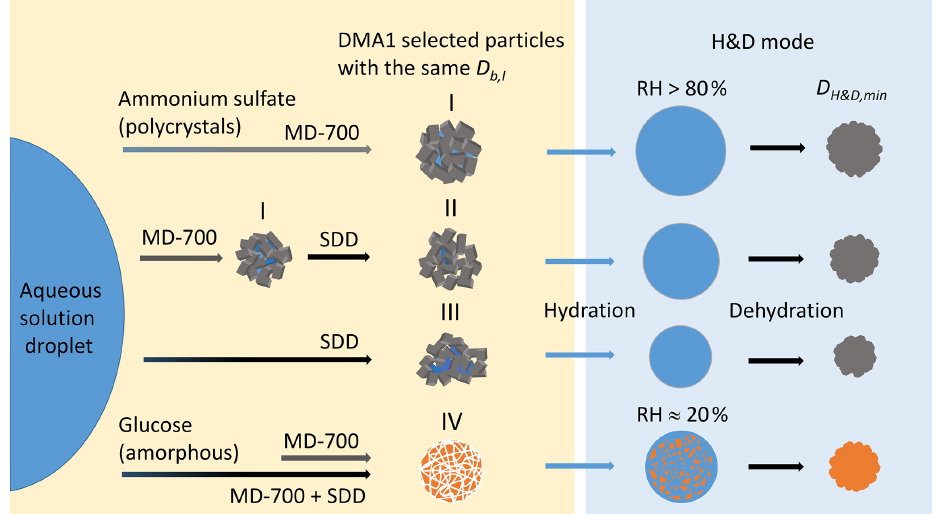
Figure 6. Possible structures of polycrystalline ammonium sulfate and amorphous glucose aerosol particles depending on drying conditions: (I) agglomerate of single crystals with fully and partly shielded cavities filled with liquid; (II, III) polycrystalline agglomerates with open and shielded cavities having a different void-to-solid ratio; (IV) amorphous glucose aerosol particle in a gel-like state. Other explanations are given in the